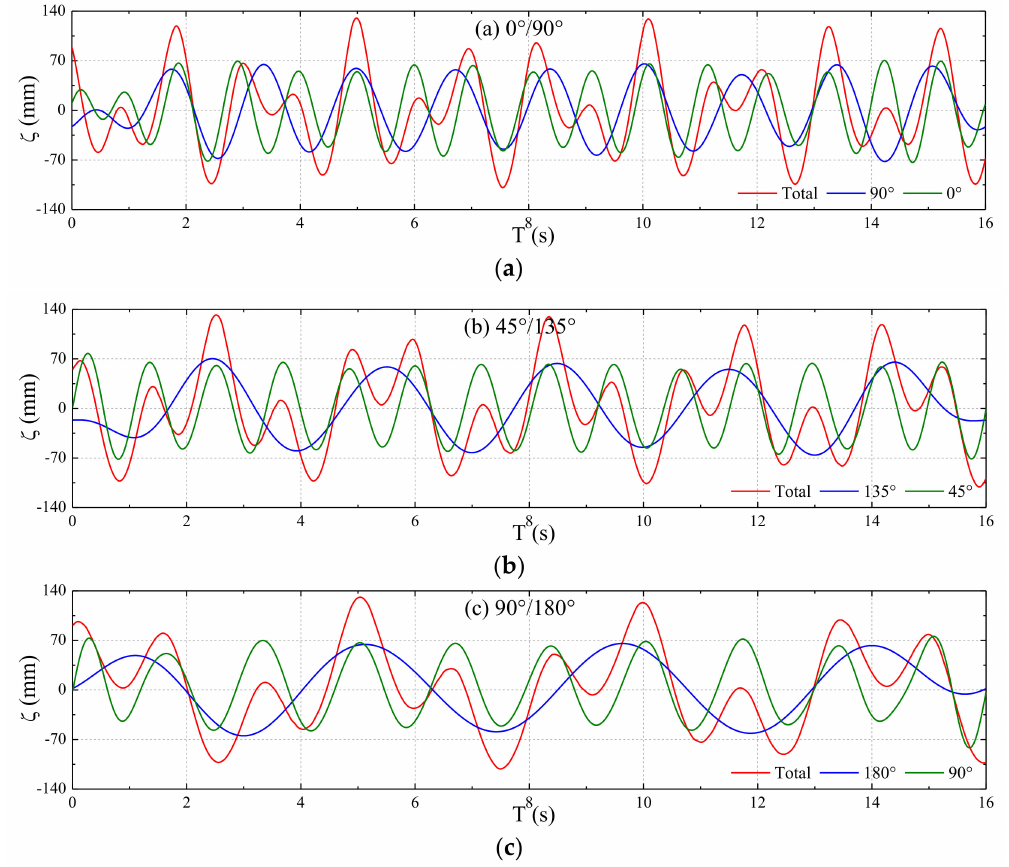
Figure 13. Wave components filtered from the measured cross wave: ( a ) 0 ◦ / 90 ◦ (Case 9); ( b ) 45 ◦ / 135 ◦